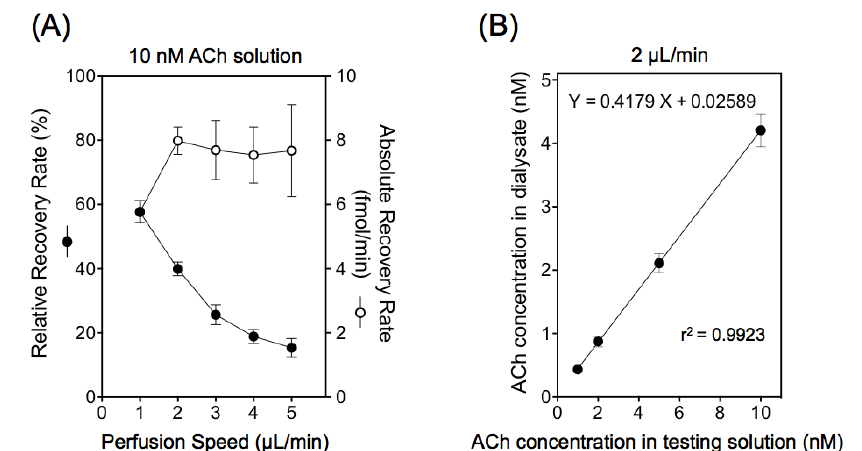
Figure 2. ( A ) The relationship between perfusion speed and relative and absolute recovery rates in vitro with 10 nM acetylcholine (ACh) in testing solution. The relative recovery rate = (concentration in dialysate)/(concentration in testing solution), and the absolute recovery rate = (concentration in dialysate) × (perfusion speed). ( B ) The relative recovery rate with different ACh concentrations in testing solution using a 2 µL/min perfusion speed. The values represent mean ± SD of 5 probes sampled for both A and B.